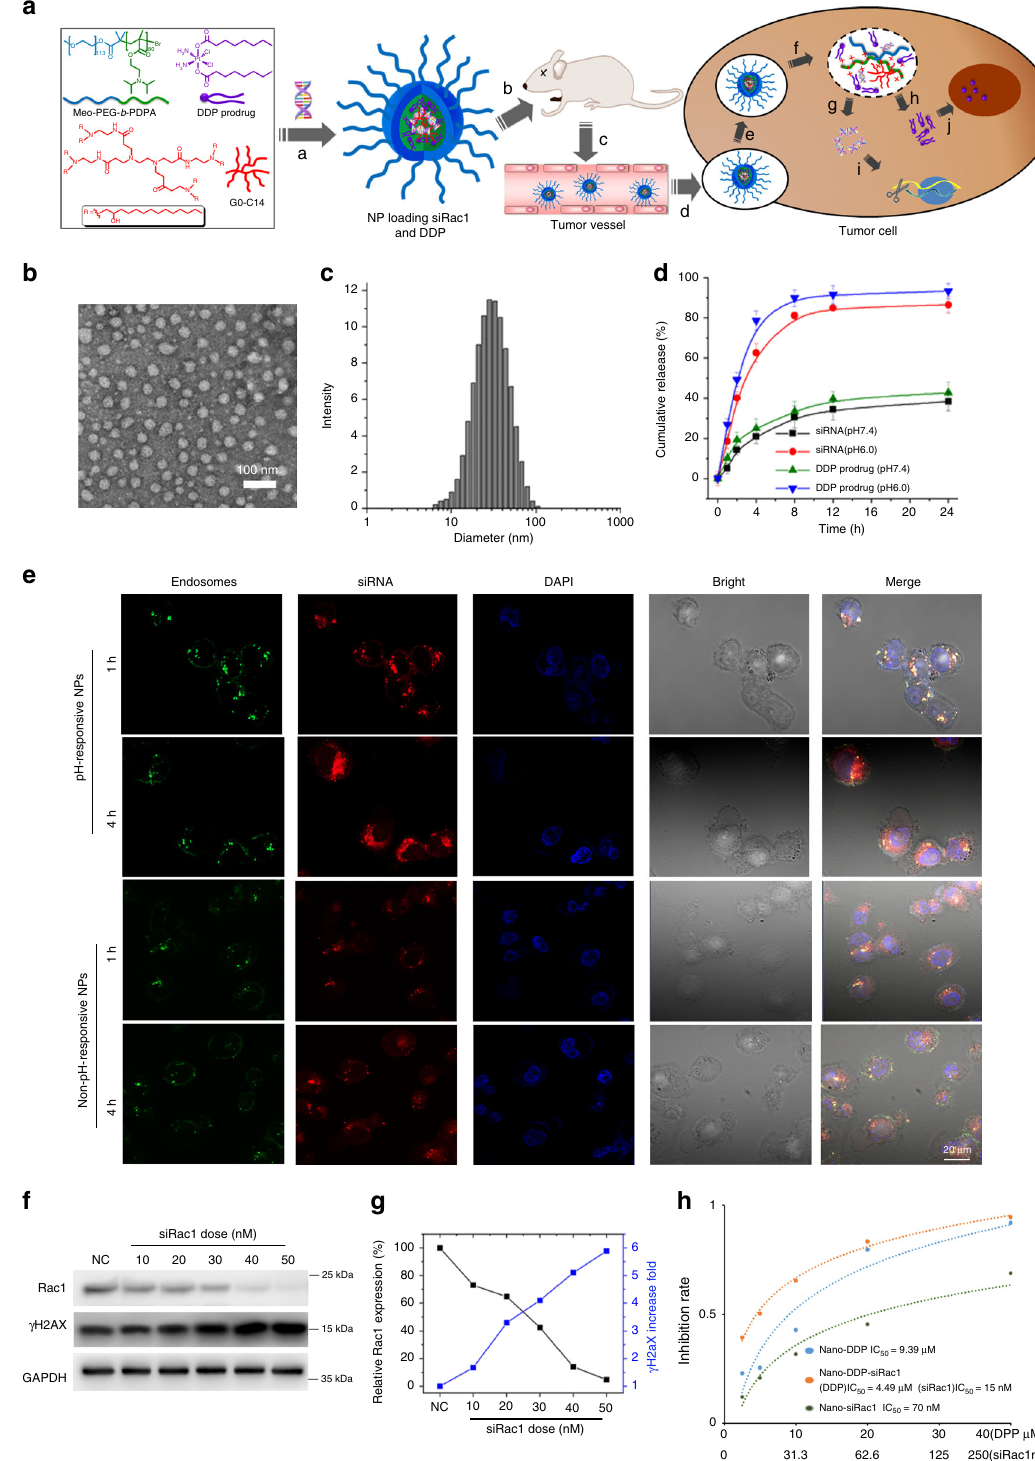
were intravenously injected into the PDX-bearing mice once every two days at a 1 nmol siRNA dose per mouse ( n = 6) (Supplementary Table 7). After three consecutive injections, the tumor growth was signi fi cantly inhibited compared to the mice treated with PBS (Control), blank NPs, or the NPs only loaded with siRac1 (Fig. 8c – e). The tumor size (Fig. 8d) and tumor weight (Fig. 8e) were about 10-fold larger in the NPs